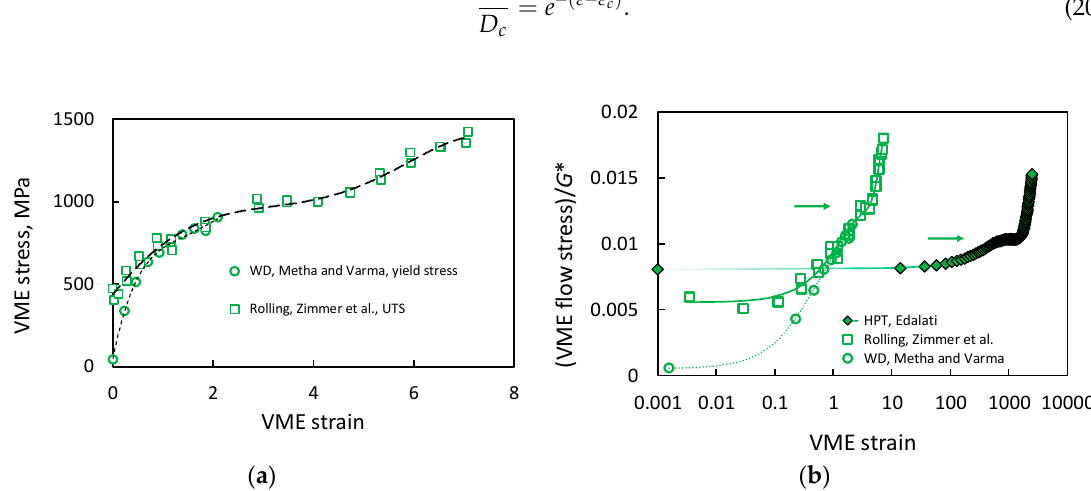
Figure 11. Stress–strain of commercial purity nickel (Ni 200, 99.4% Ni) deformed by ( a ) wire drawing (replotted from [69] and rolling (replotted from) [71]) compared with ( b ) the behavior of 99.996% Ni deformed by HPT (ultra-severe SPD) (replotted from [56]). In figure ( b ) arrows point to the seeming ultra-SPD